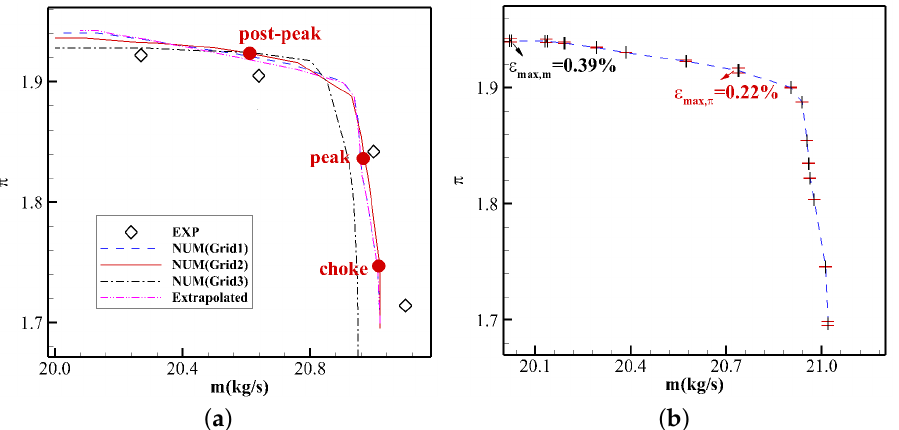
Figure 11. Total pressure ratio against the mass flow rate at 100% design speed ( a ); fine-grid solution, with discretization errors computed using the corresponding equations in reference [32] ( b ).